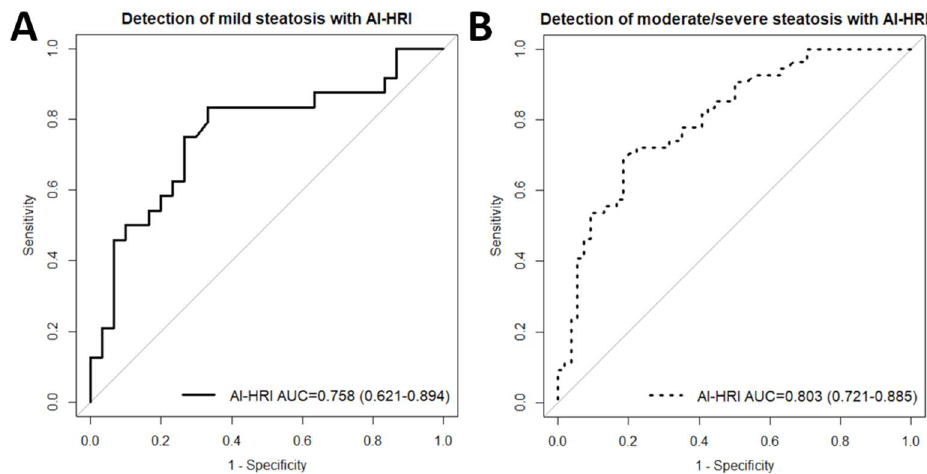
Figure 4. ( A ) The plot shows receiver operating characteristics (ROC) curve analyses with artificial intelligence-calculated hepatorenal index (AI-HRI) for the classification of normal liver and mild steatosis. The accuracy of AI-HRI was fair based on the area under the curve (AUC) value of 0.758. The 95% confidence intervals of the AUC are listed inside the brackets. ( B ) The plot shows that AI-HRI could detect moderate/severe steatosis with an AUC of 0.803, indicating good classification accuracy. The magnetic resonance imaging fat fraction (MRI-PDFF) was used as the reference method in both classifications. Table 3. Performance metrics from ROC analyses with QUS parameters. Method Thresh.